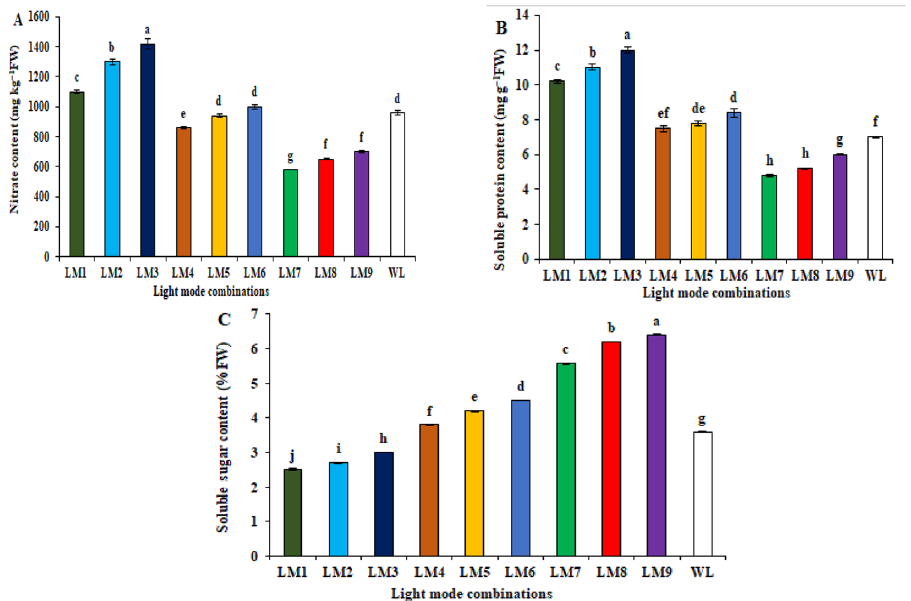
Figure 3. Effect of modes LED light on biochemical traits; Nitrate content ( A ), Soluble protein content ( B ), and Soluble sugar content ( C ) in cucumber seedlings. Means followed by the same letter within the same series are not significantly different according to Duncan’s multiple range test ( P ≤ 0.05). See Table 4 for LM